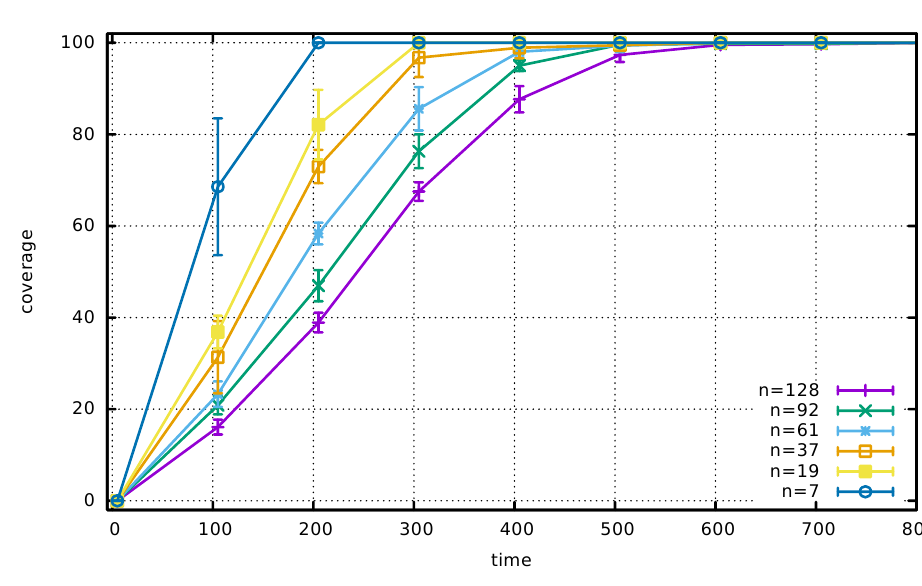
Fig. 3: The percentage of covered area along time for different number of